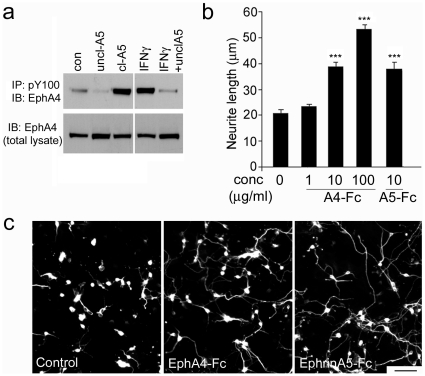
Unclustered ephrin-A5-Fc and EphA4-Fc promote neurite outgrowth.(A) Immunoprecipitation (IP) of phosphotyrosine containing proteins using anti-pY100 antibody followed by immunoblot (IB) for EphA4 showed that unclustered ephrin-A5-Fc (uncl-A5) inhibits basal and IFNγ-induced EphA4 receptor phosphorylation in cultured astrocytes, whereas clustered ephrin-A5-Fc (cl-A5) upregulates EphA4 receptor phosphorylation. (B–C) Inhibition of neurite outgrowth on astrocytes was blocked in a dose-dependent manner by addition of unclustered EphA4-Fc; 10 µg/ml of EphA4-Fc and ephrin-A5-Fc were used in (C). Results in B show mean±SEM, ***p<0.001, using one-way ANOVA with Tukey's multiple comparison test, from n≥100 neurons per condition, representative of n = 3 experiments. Scale bar in C, 100 µm.